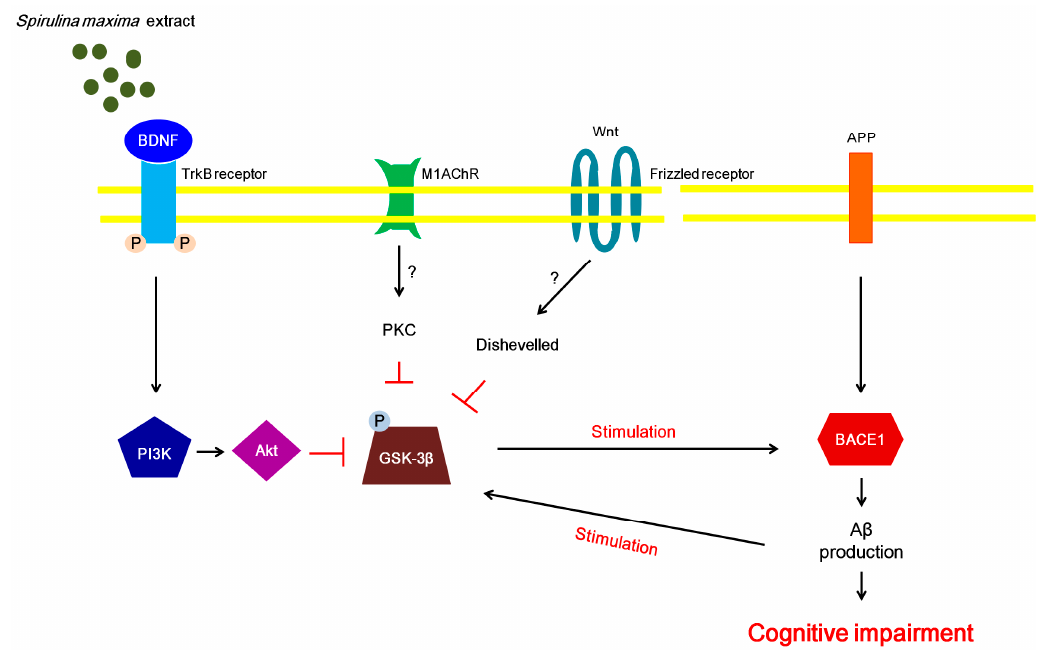
Figure 5. Proposed mechanism whereby SM70EE ameliorates learning and memory impairments in mice with an intracerebroventricular injection of amyloid- β 1–42 (A β 1–42 ). The 70% ethanol extract of Spirulina maxima (SM70EE) inhibits phosphorylation of GSK3- β , which is regulated by the activation of the brain-derived neurotrophic factor (BDNF)/phosphatidylinositol-3 kinase (pPI3K)/serine/threonine protein kinase (Akt) signaling pathway. → indicates stimulation; ⊥ , inhibition, ?, unclear action; APP, amyloid precursor protein; BACE1, β -site APP-cleaving enzyme 1; M1AChR, muscarinic acetylcholine receptor M1; PKC, protein kinase C; TrkB, tropomyosin receptor kinase B.